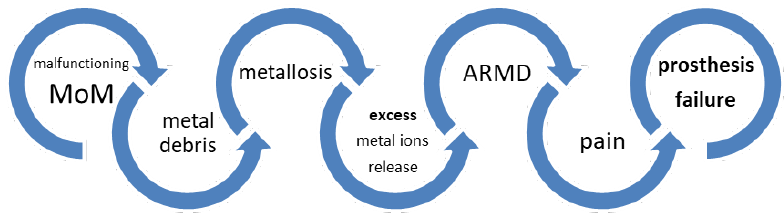
Figure 1. Events leading to loss of function of a metal-on-metal (MoM) hip replacement. ARMD, adverse reaction to metal debris.